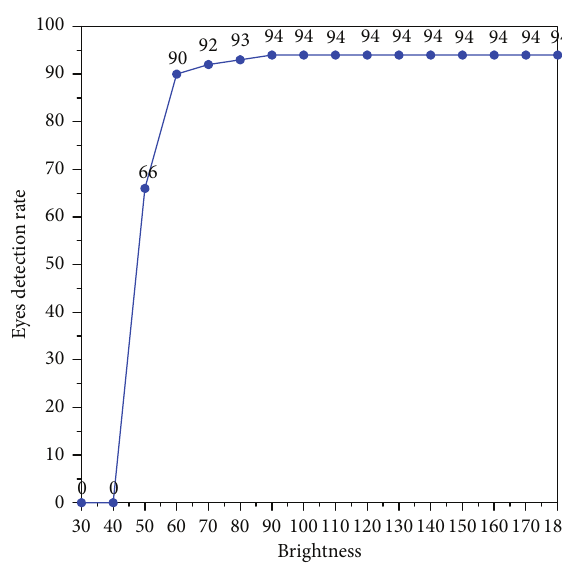
Figure 15: The relationship between detection rate and brightness.